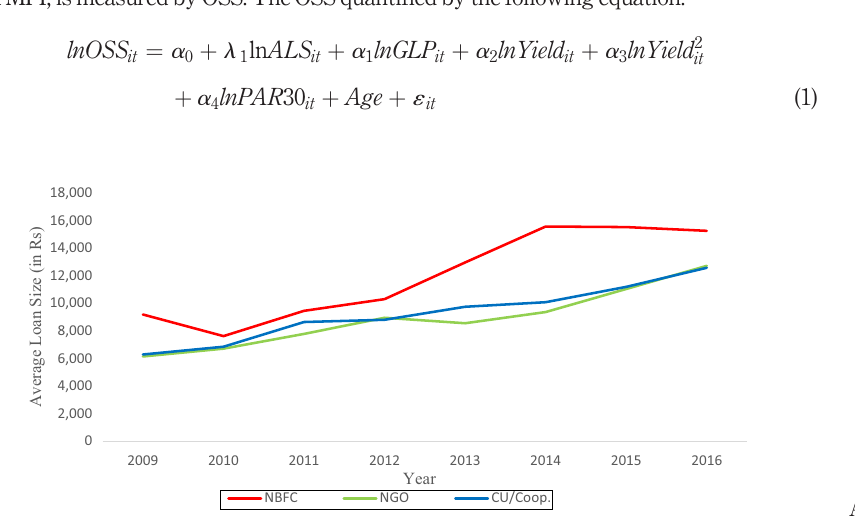
Figure 2. Average loan size